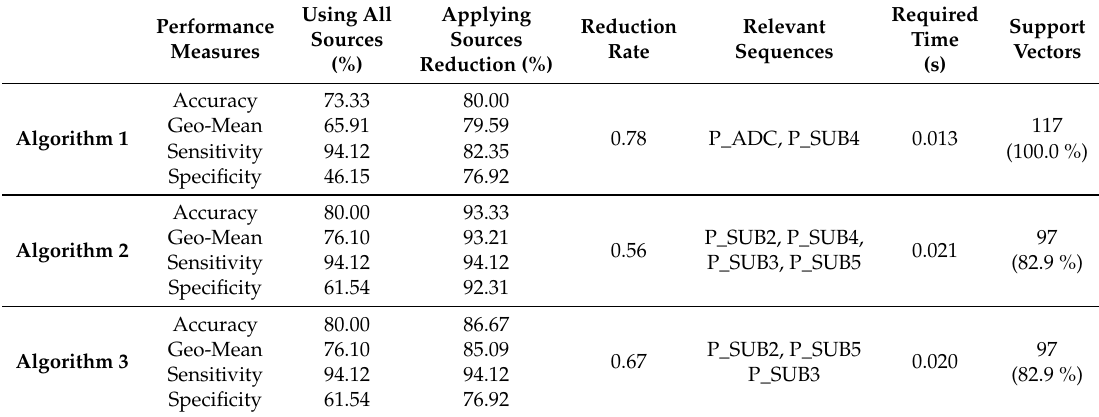
Table 5. Results of selection of MRI sequences with perceptual features and (cid:96) 1 -norm.